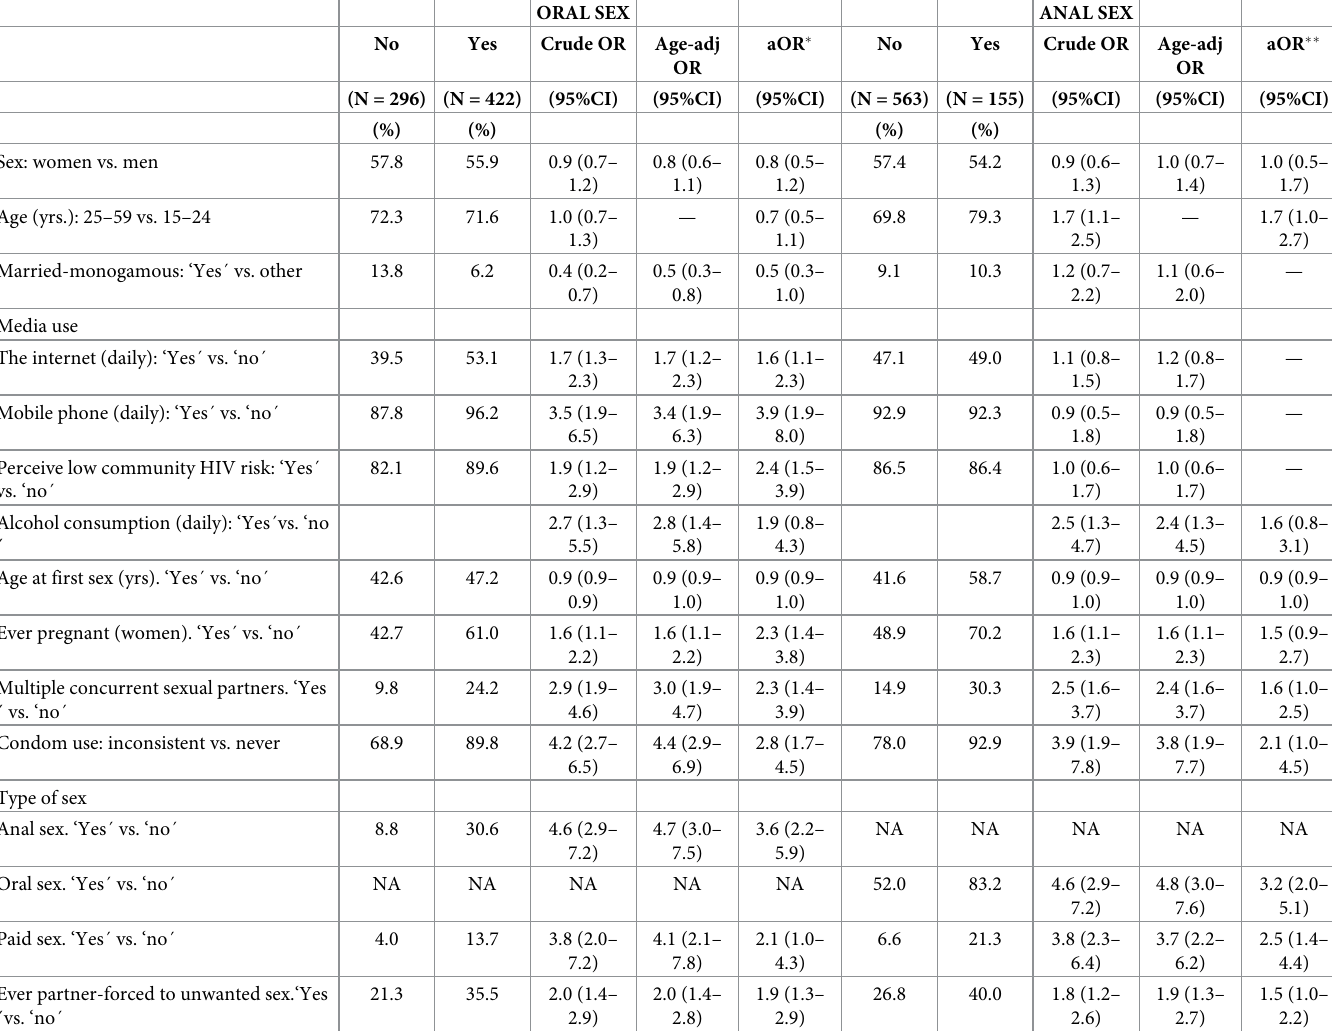
Table 1. Factors associated with oral and anal sex among the sexually active OKAPI cohort participants (N = 718).